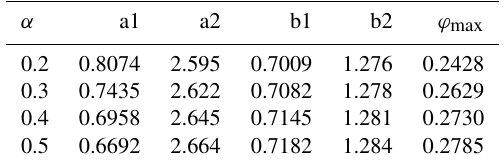
Table 1. Parameters to calculate the viscosities for a melt network consisting of 50% tubes and 50% films using Eqs. (24) and